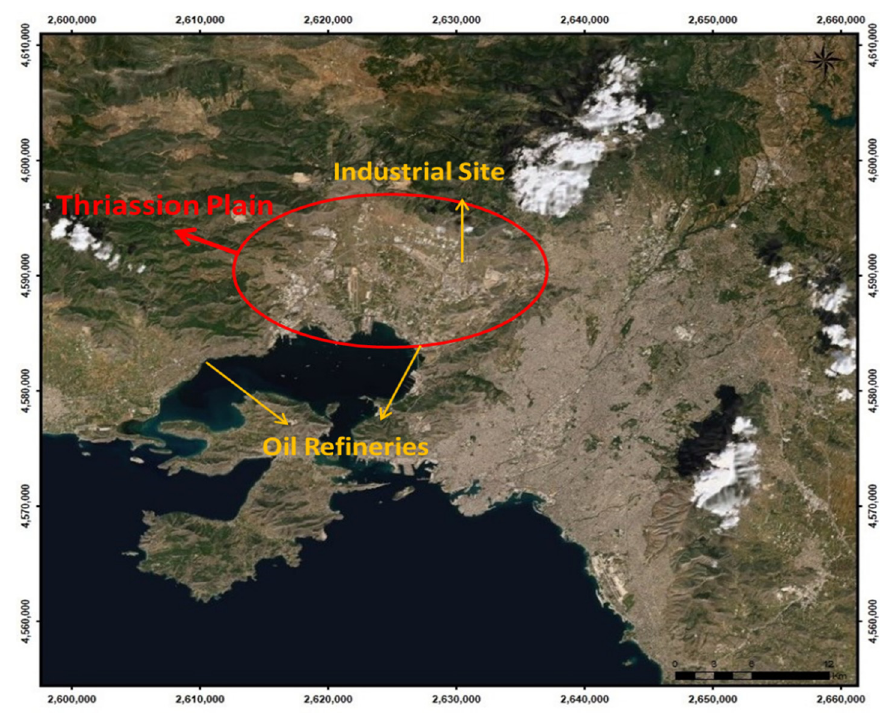
Figure 1. The sampling point in the Thriassion Plain and the nearby capital Athens.